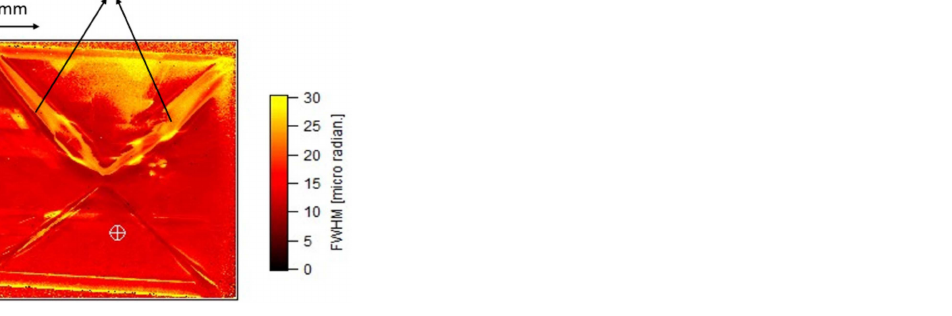
Figure 5. The FWHM map generated from the rocking curve map of a type 1b HPHT diamond plate of dimensions 5 mm × 5 mm in the (220) plane. The thick, long contrast lines support the results of Figure 3, implying a high density of dislocations propagating along the <111> direction. The centre of the crystal also has a high density of defects. The FWHM values for the entire sample range from about 4 arc sec to 8 arc sec (1 Micro radian = 0.206 arc sec). The scale bar is 1